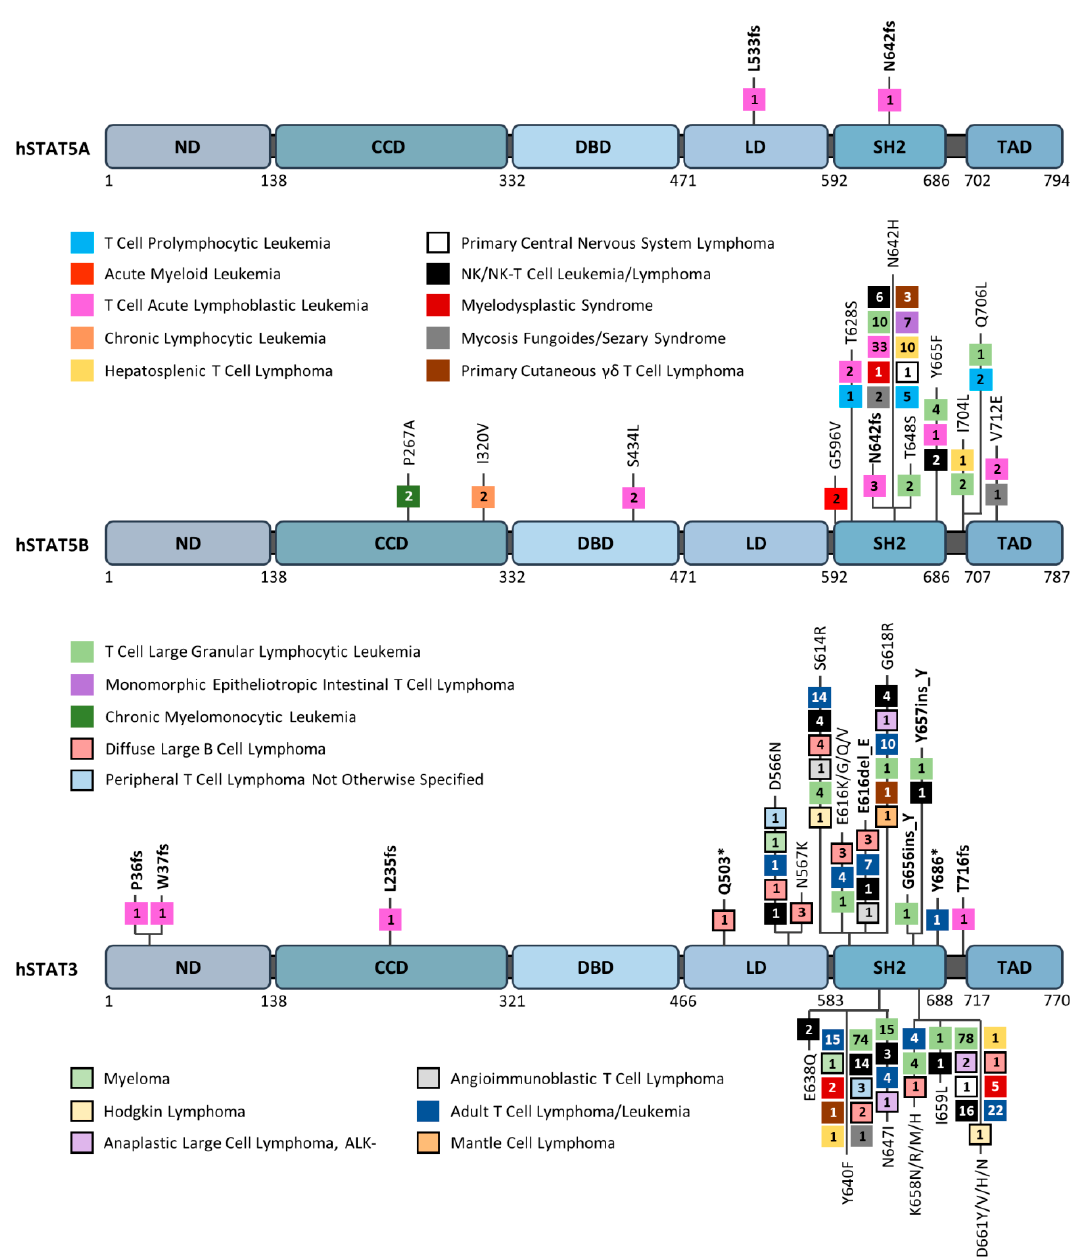
Figure 2. Map of somatic mutations detected in human STAT5A, STAT5B, and STAT3 in patients with hematologic cancers. Individual missense mutations found in at least two patients, as well as all reported nonsense (*) and frameshift (fs) mutations (bold), are depicted. The numbers in each box represent the number of cases reported for each mutation. Data were mined from the Catalogue of Somatic Mutations in Cancer (COSMIC) database. ND, NH2-terminal domain; CCD, coiled-coil domain; DBD, DNA binding domain; LD, linker domain; SH2, Src homology 2 domain; TAD, transactivation domain.